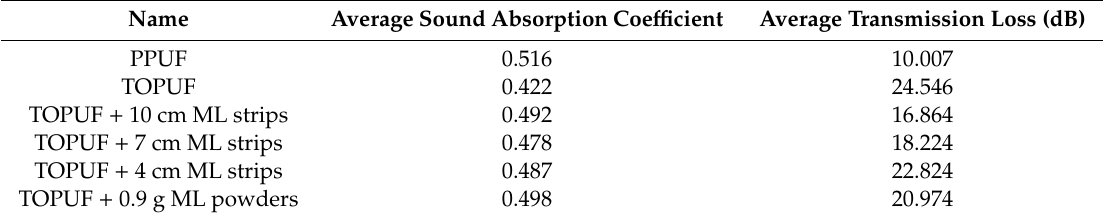
Figure 10. Sound absorption coefficient ( a ) and transmission loss ( b ) of TOPUF adding different forms of ML. Table 5. Average sound absorption and transmission loss of TOPUF adding different forms of ML.